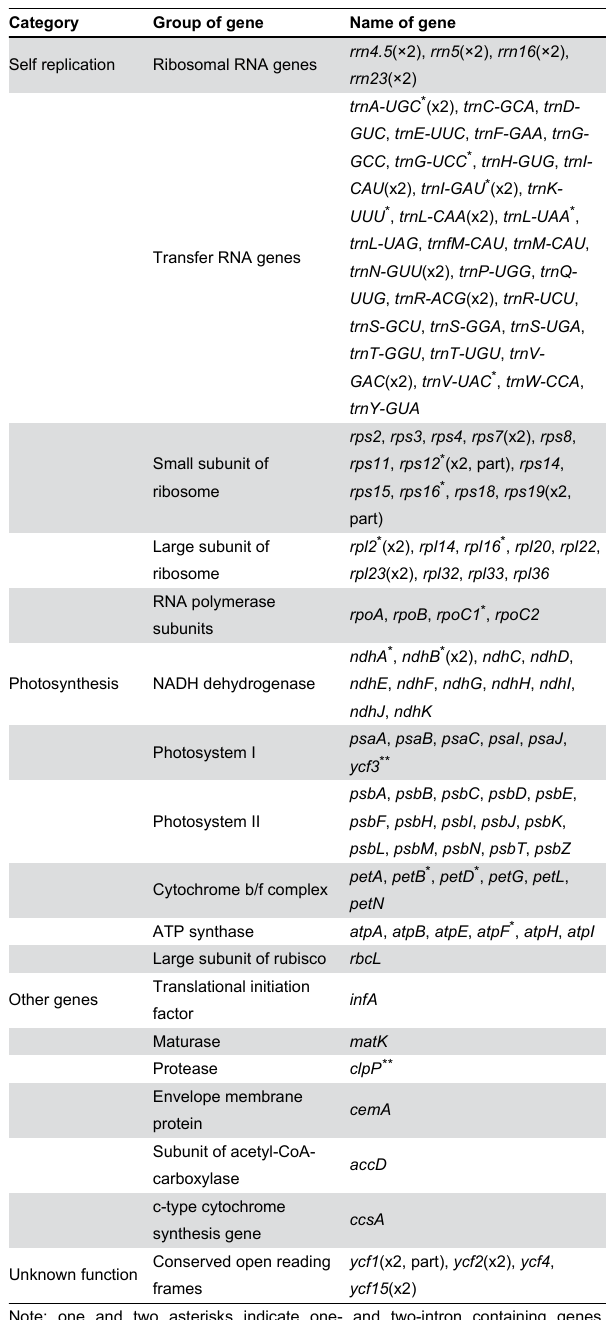
Note: one and two asterisks indicate one- and two-intron containing genes, respectively. Genes located in the IR region are indicated by (×2) after the